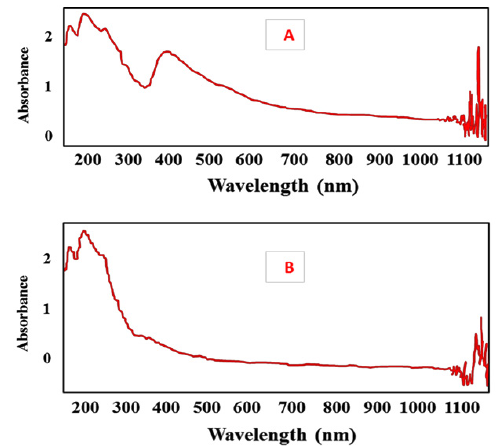
Fig. 12. UV spectra of Acid orange dye before treatment with silver nanoparticles (A); after treatment with silver nanoparticles